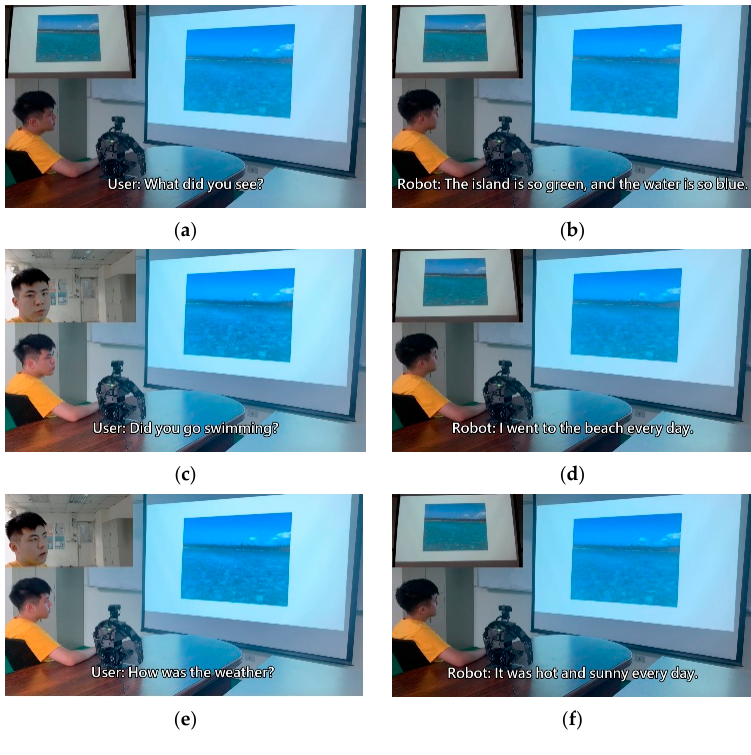
Figure 14. Experimental result in scenario B.